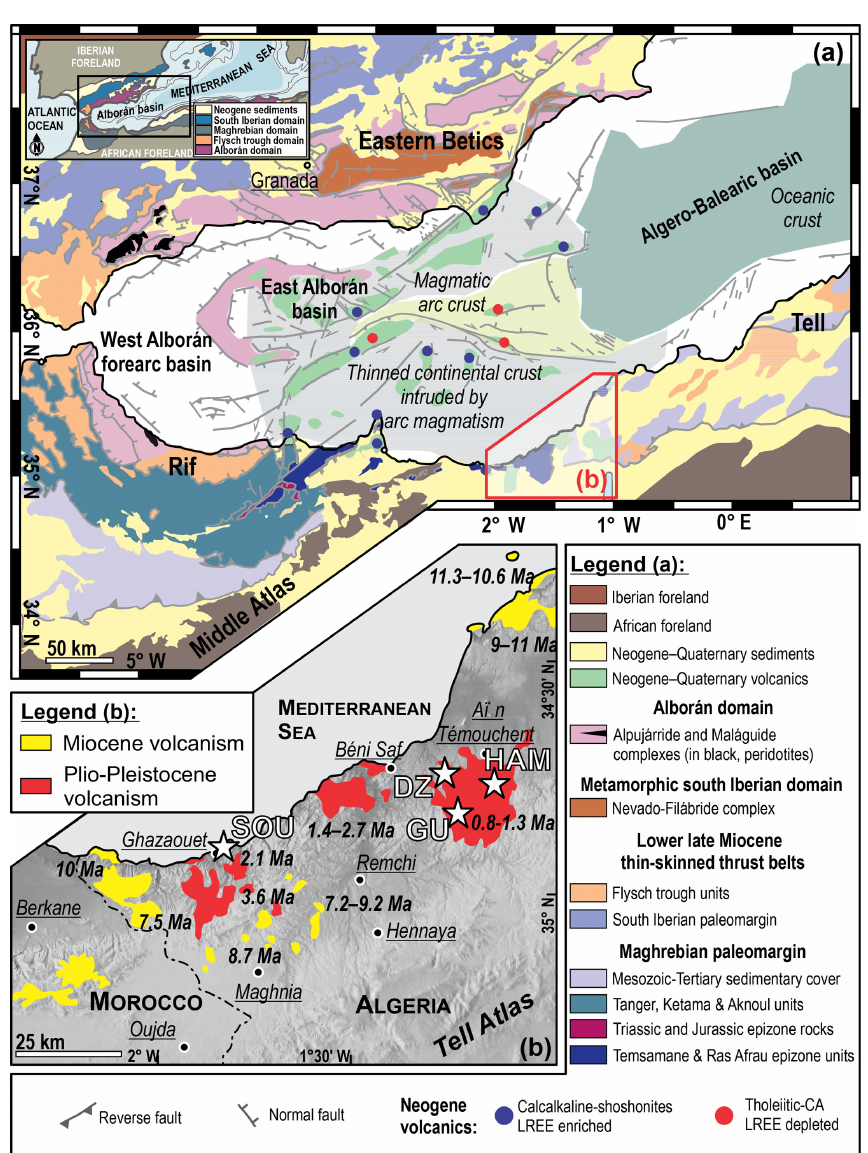
Figure 1. (a) Simplified geological map of the westernmost Mediterranean, showing the main tectonic domains of the Betic–Rif orogenic belt with the areas of oceanic crust, magmatic arc and thin continental crust in the Alboran basin (modified after Booth-Rea et al., 2007, and references therein). The area in a red frame indicates the Oran volcanic field, and it is enlarged in panel (b) . (b) Schematic map of the Oran volcanic field showing the occurrences of Miocene and Plio-Pliocene volcanic rocks. Italic numbers correspond to the age of volcanism after Maury et al. (2000) and Duggen et al. (2005). White stars indicate the location of the studied mantle xenoliths with the prefix of the sample labels as DZ (Djebel Dzioua), GU (Djebel Gueriane), HAM (Hammar E’Zohra) and SOU